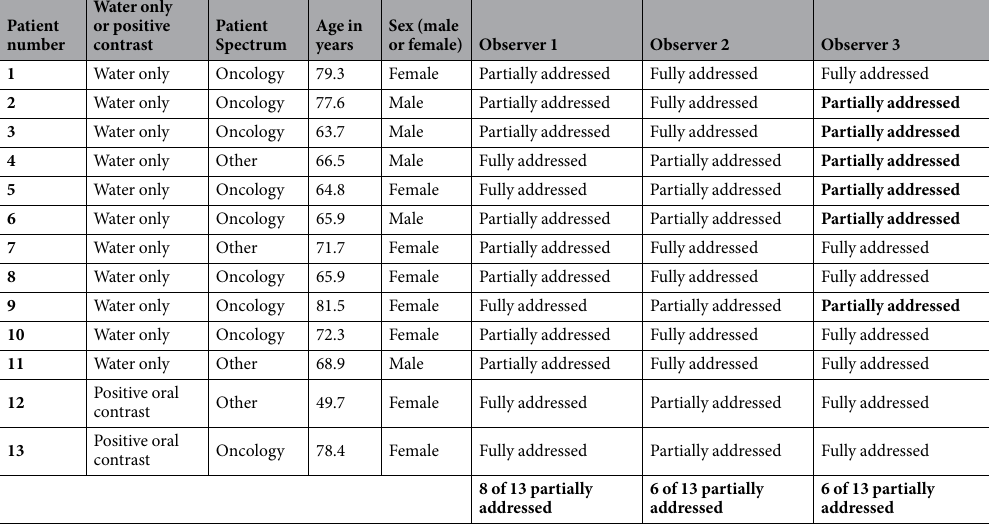
Table 4. Patients with partially assessed overall diagnostic confidence by either